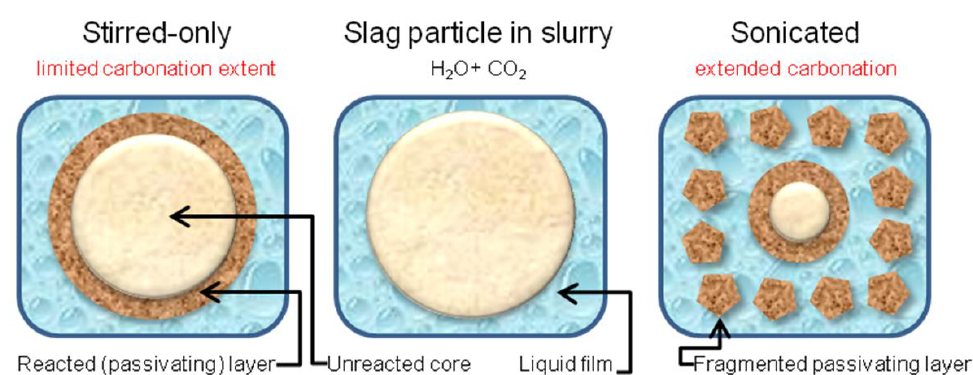
Figure 2. Ultrasound-intensified mineral carbonation. Reprinted from Applied Thermal Engineering, vol. 57, Santos et al. [26], 154-163, Copyright 2012, with permission from